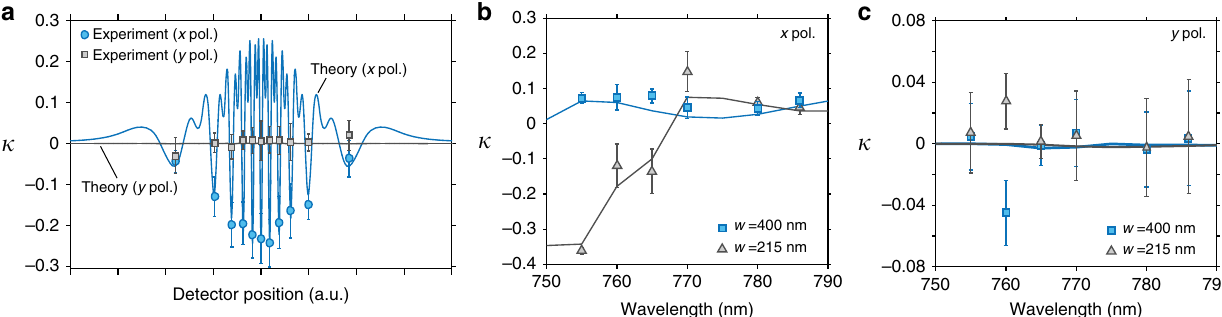
Detector position (a.u.) Figure 4 | Quantifying the contribution of looped trajectories through the normalized Sorkin parameter, j . ( a ) Shows numerical and experimental results, for a sample with w ¼ 200nm, h ¼ 100 m m and p ¼ 4.6 m m and an illuminating field consisting of heralded single-photons at a wavelength of 810nm. The experimental points are obtained by measuring k at different peaks of the interference patterns shown in Fig. 3. ( b ) Shows theoretical and experimental evidence at the central maximum for different widths and for various wavelengths for an attenuated laser diode, in this case the contributions from looped paths makes the k different from zero. ( c ) Shows a situation in which looped trajectories are not enhanced and consequently k is almost zero. These results confirm that the strengths of looped trajectories can be controlled by engineering the size of the slits and the wavelength of the illuminating field. These values of k were measured at the center of the interference pattern. The error bars represent the standard deviation over the ensemble of measurements. The labels x and y indicate the polarization state of the incident